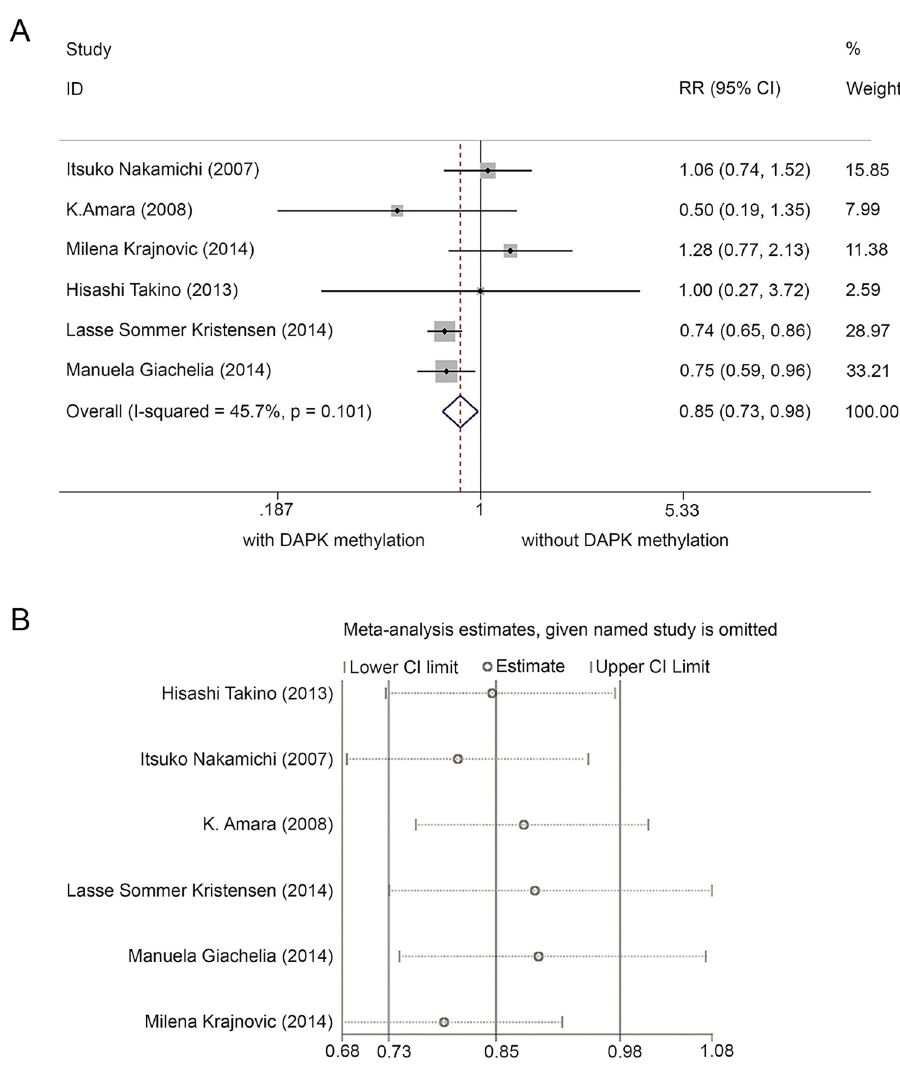
Fig 2. Association of DAPK methylation with 5-year survival rate in patients with lymphoma. (A) Forest plot (B) Sensitivity analysis.